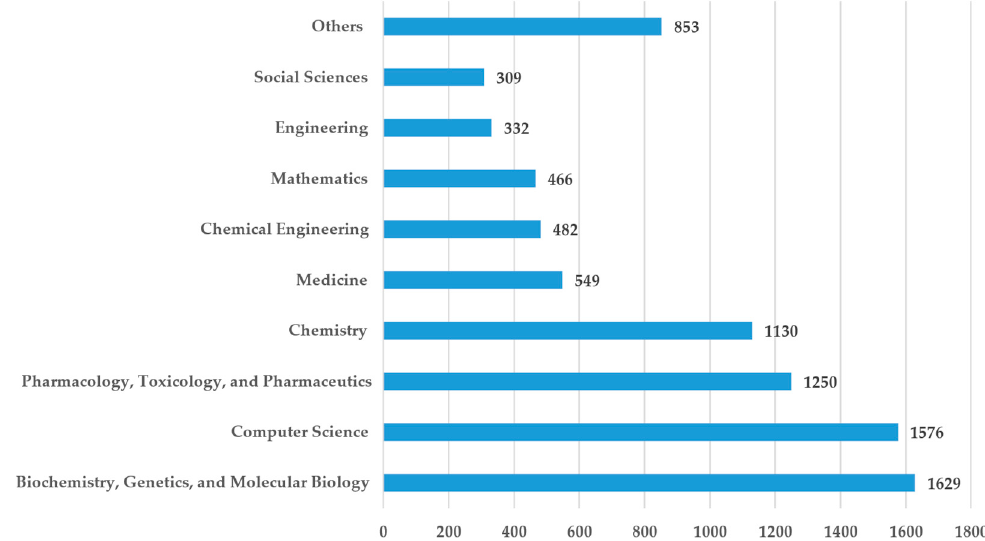
Figure 1. Distribution of the publications among disciplines.